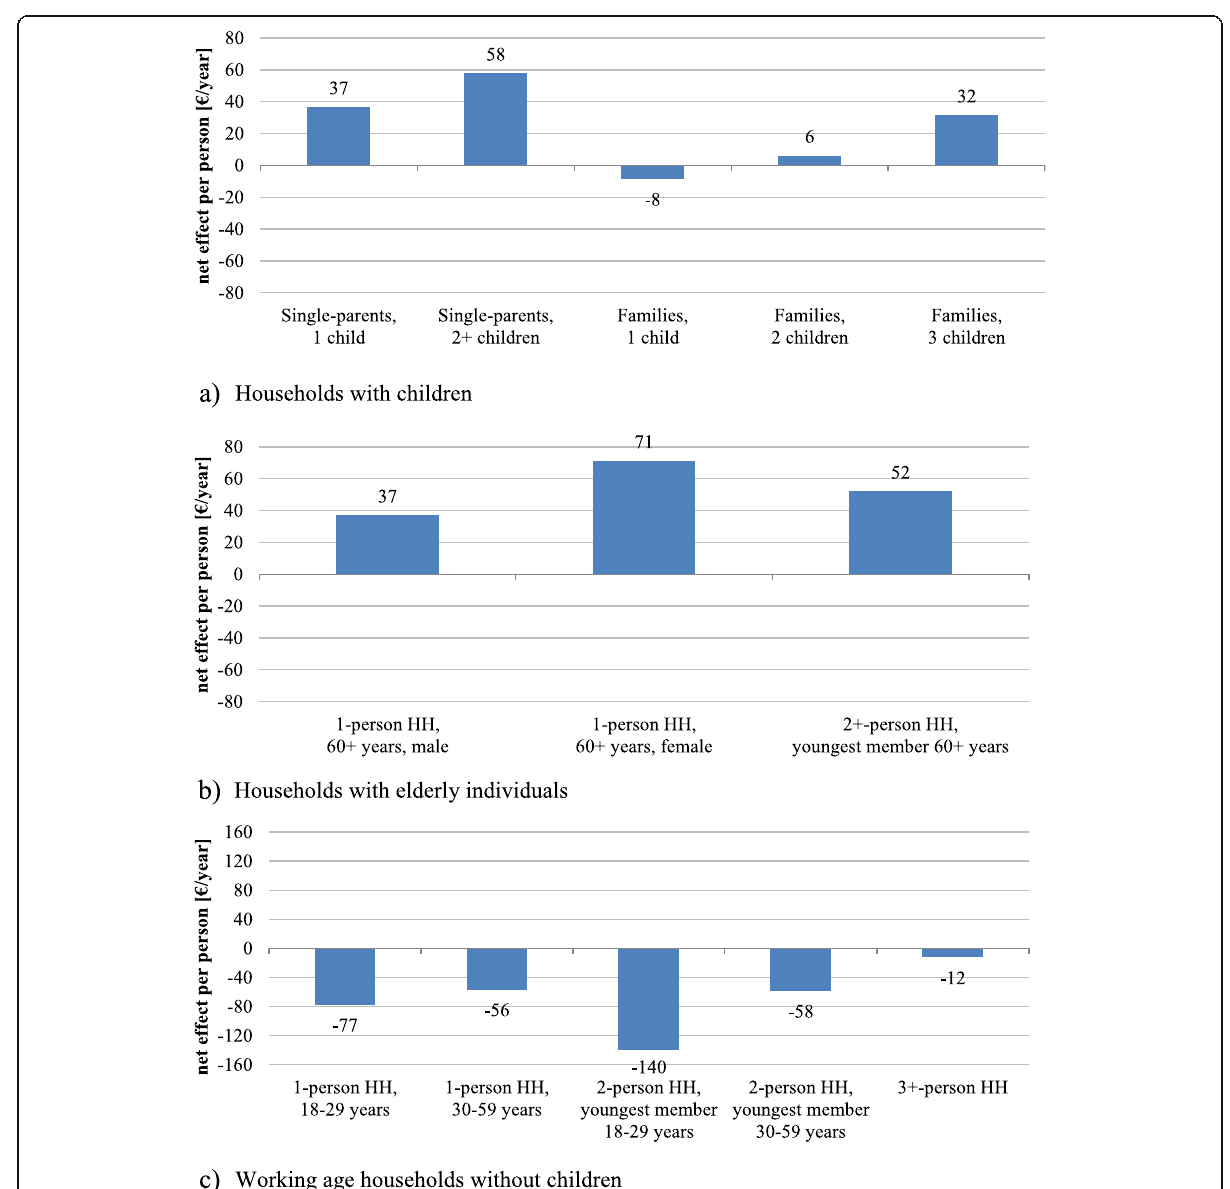
Fig. 3 Net effects of carbon taxation, differentiated by household types. a Households with children. b Households with elderly individuals. c Working age households without